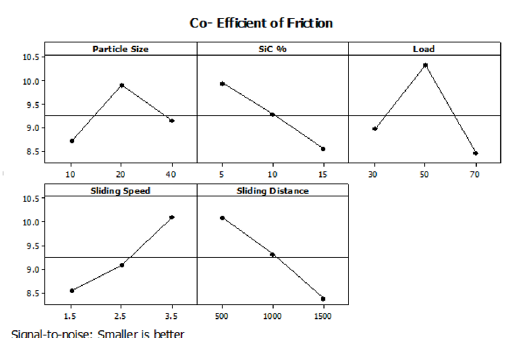
Figure 3. Influence of various parameters on S/N ratio for friction co-efficient (smaller is better)